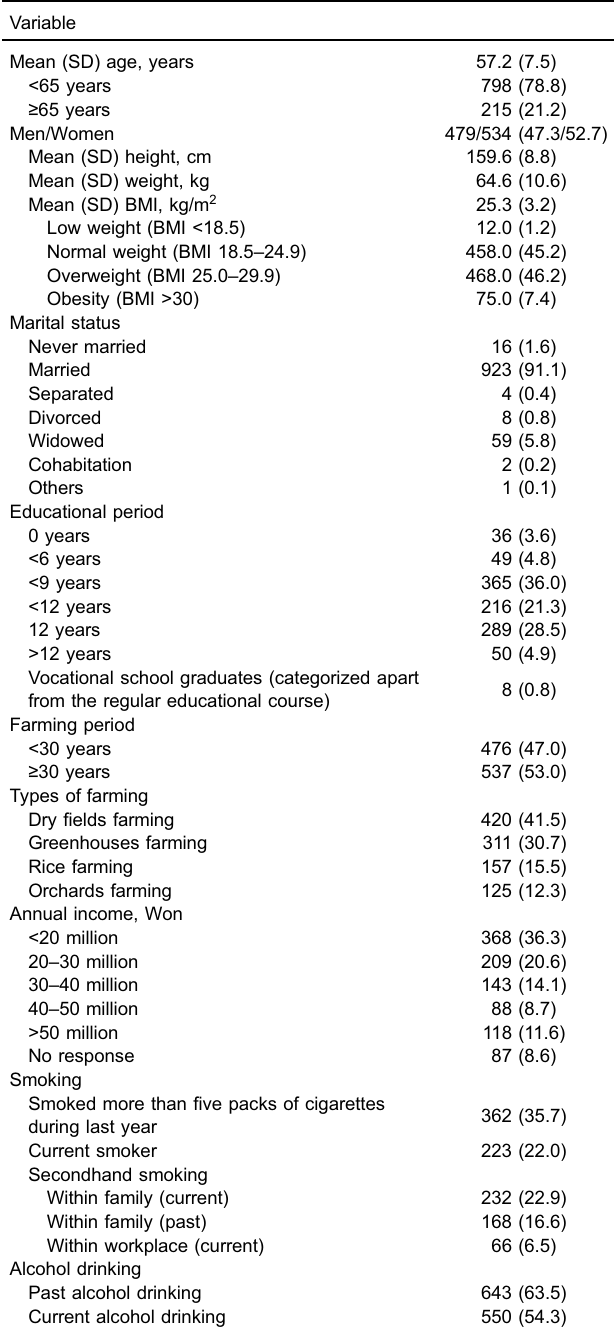
Table 3. Baseline characteristics of enrolled subjects ( n =